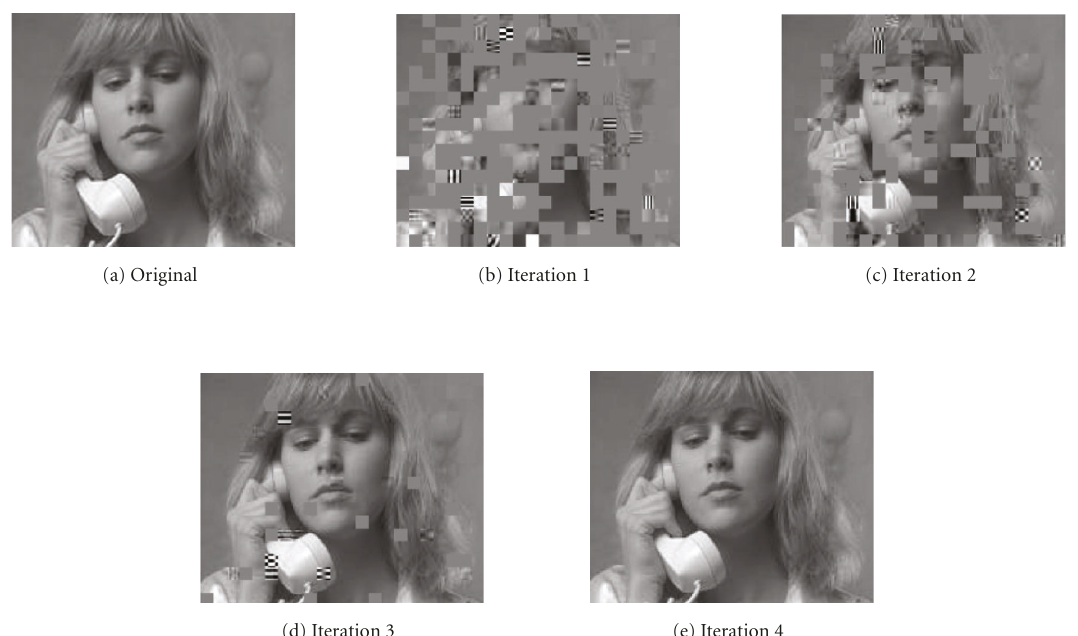
Figure 11: Original and decoded “Suzie” images over AWGN channel using proposed asymmetric turbo code with interleaver with an E b /N 0 of